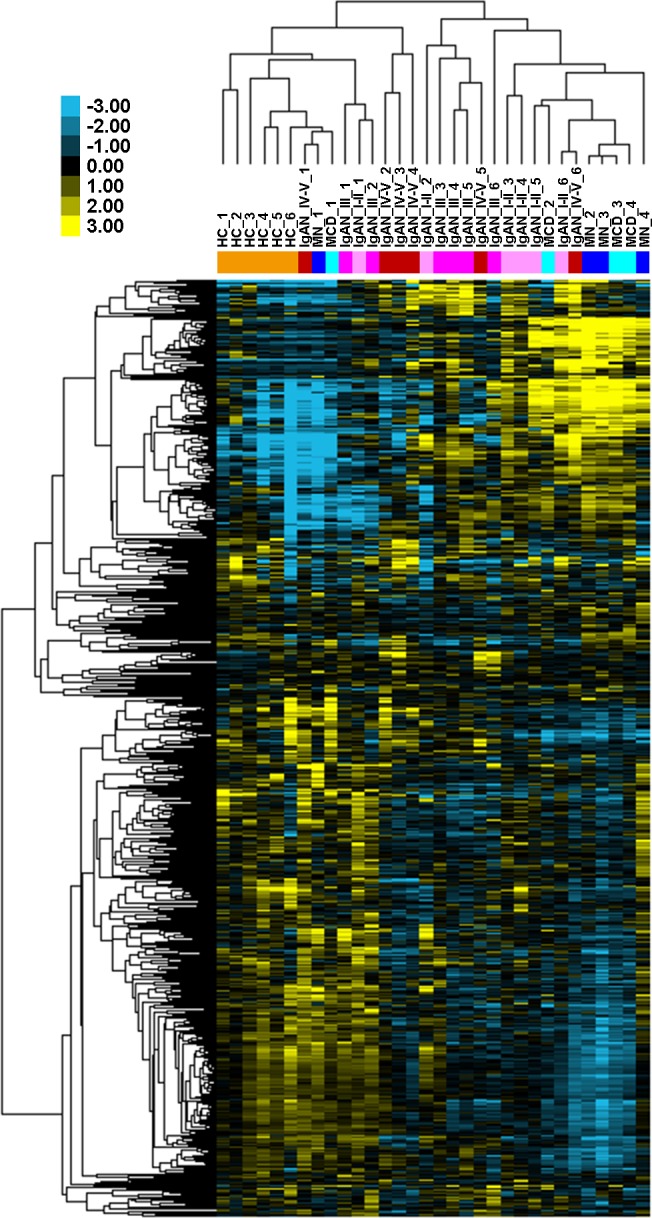
Global urinary miRNA profiling in patients with IgAN and controls.Unsupervised hierarchical clustering using log2-transformed microarray signal values of the 780 expressed miRNAs is shown as a heat-map. Columns represent urine samples and rows miRNAs. Urine samples were from 18 patients with IgAN (red), 6 healthy subjects (orange), 4 patients with MN (dark blue) and 4 patients with MCD (light blue). Heat-map colours represent relative miRNA expression as indicated in the colour scale: yellow represents high expression; blue represents low expression; black respresents median expression level equal to 1. HC, healthy control; IgAN, IgA nephropathy; I–II, III and IV–V, grade I–II, III and IV–V according to Lee’s grading system, respectively; MN, membranous nephropathy; MCD, minimal change disease.